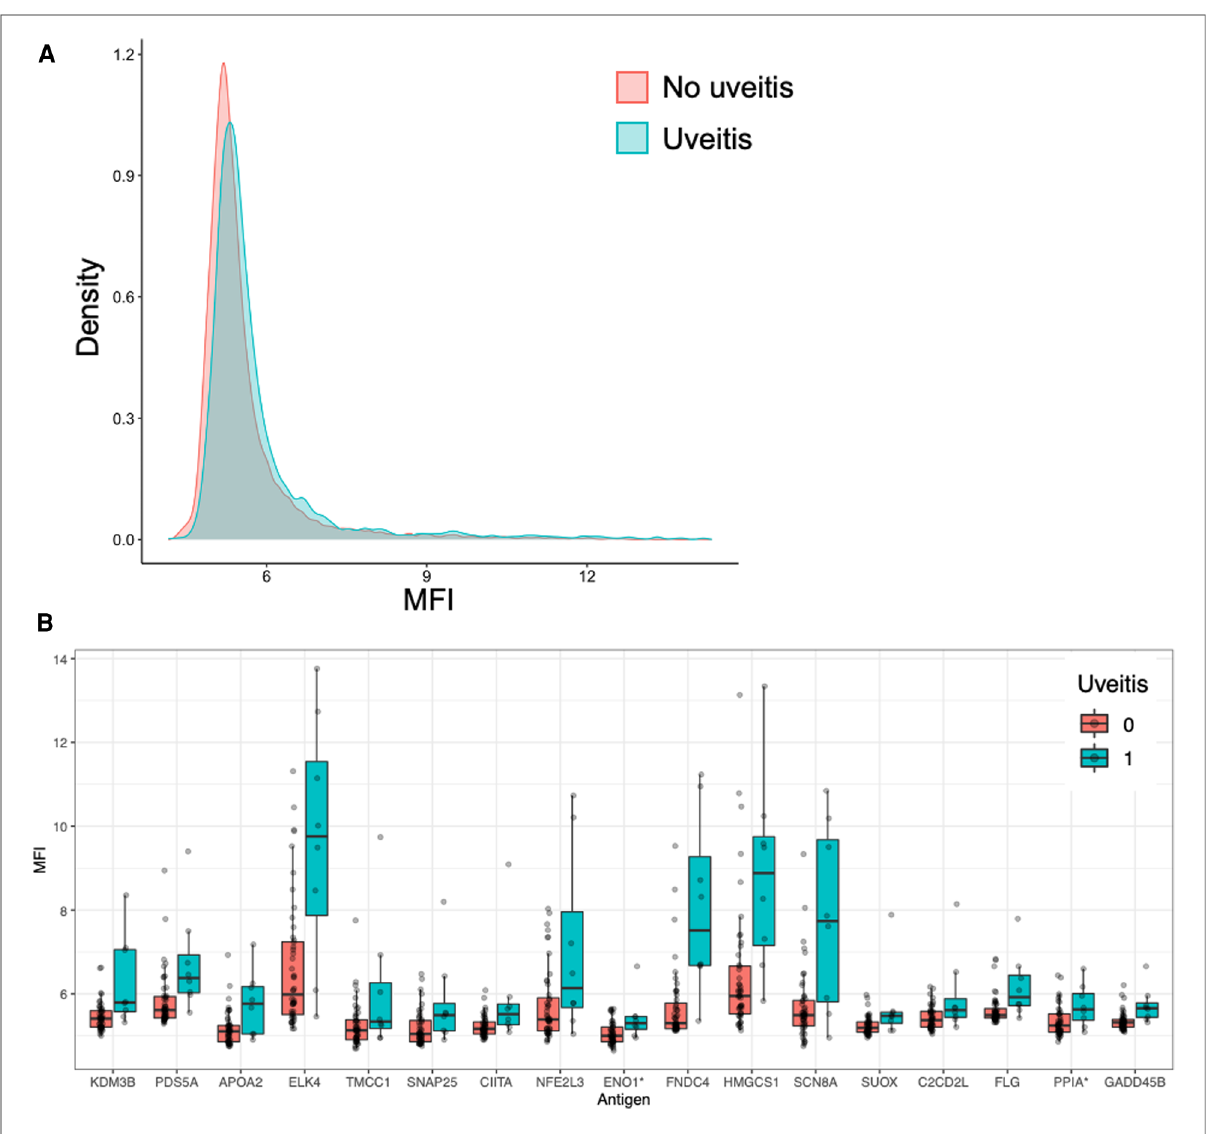
FIGURE 3 JIA patients with uveitis have increased autoreactivity. ( A ) Histogram of distribution of MFI across all 335 antigens in the bead array, grouped by uveitis. ( B ) Reactivity towards the 17 antigens which were signi fi cantly associated with uveitis in the bead array, presented as MFI values. Each dot represents a